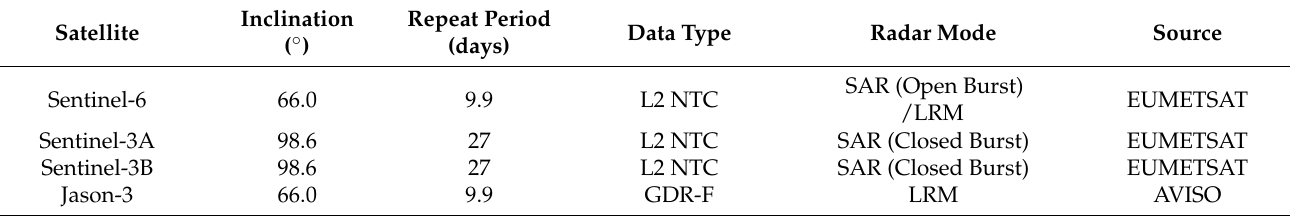
Table 1. Information of the satellite altimetry data